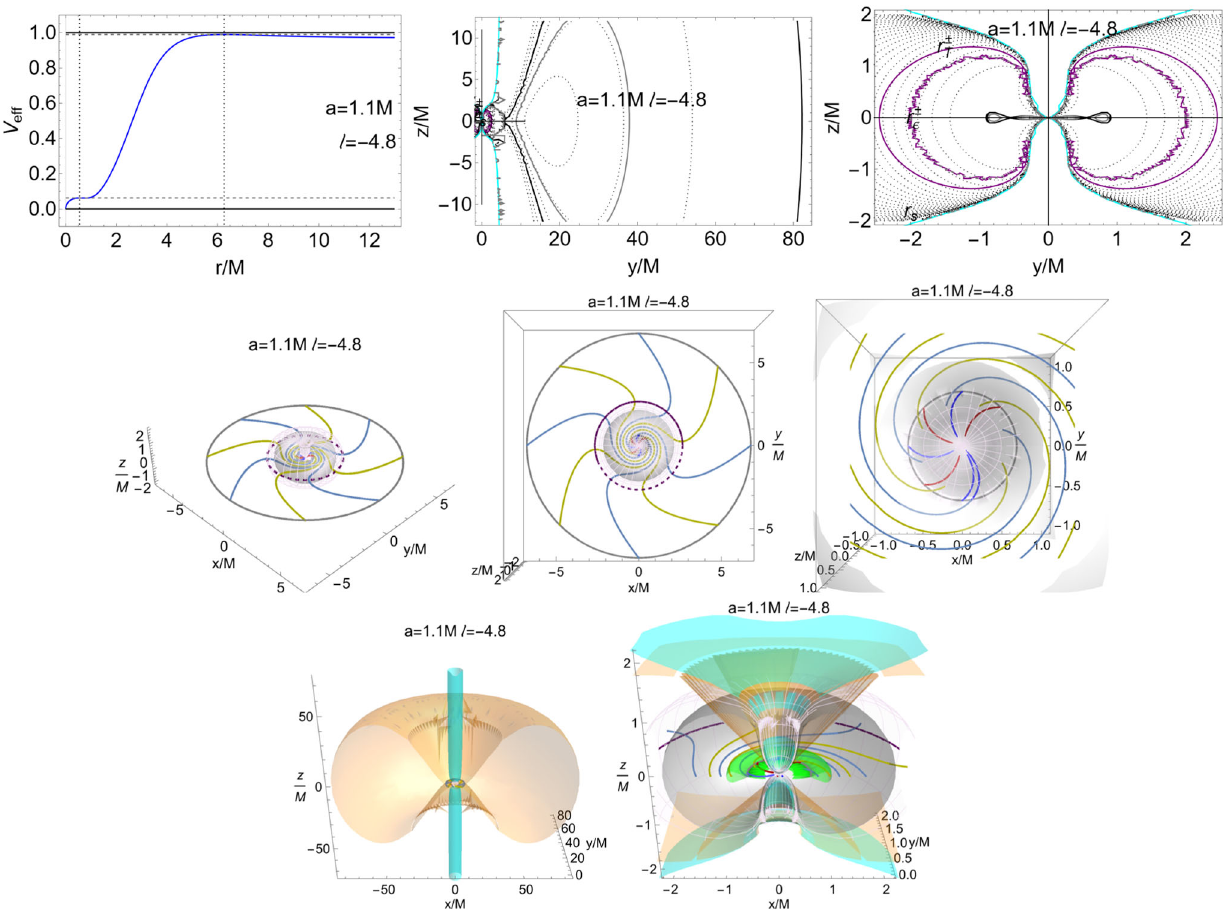
Fig. 11 Photon orbits with trajectories inversion points in the NS geometry with spin a = 1 . 1 M . The (counter-rotating) particle flows specific angular momentum is (cid:6) = − 4 . 8. There are two orbiting counter-rotating tori with (cid:6) − = (cid:6) + = − 4 . 8. In Fig. 12 there is the analysis for the test particles trajectories. The initial radius is r 0 < r × , where r × is the torus inner edge (cusp). The inversion sphere r (cid:2) is the light-purple surface. On the equatorial plane radius r ± (cid:2) is the purple curve. Upper line: left panel shows the effective potential for the sys- tem of two counter-rotating tori. Dotted curves show the location of tori cusps r × . Center panel: equi-density surfaces an outer torus, cyan curve